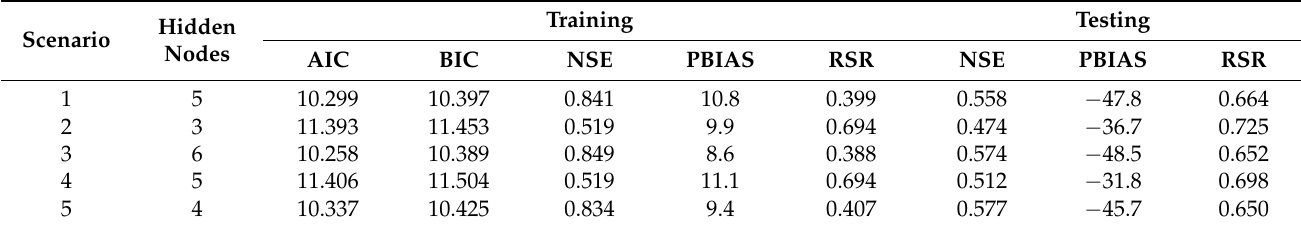
Table 3. AIC selected models with the optimum number of hidden nodes, HSARB.